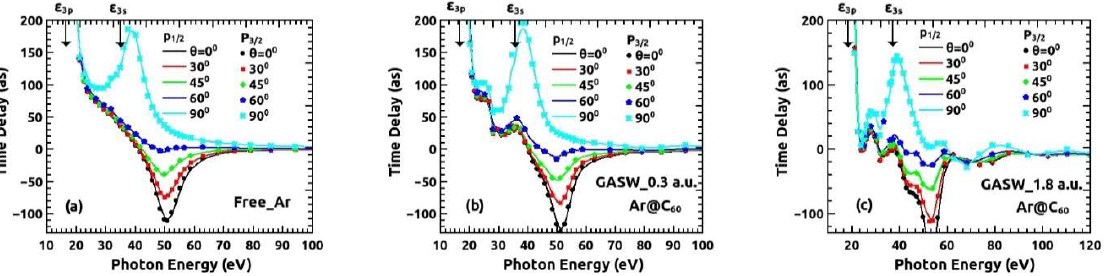
Figure 5. Spin average, angle-dependent time delay of photoionization from the 3p 1/2 and 3p 3/2 subshells of ( a ) free ( left panel ) and confined Ar with the depths of ( b ) 0.3 a.u. ( middle panel ) and ( c ) 1.8 a.u. ( right panel ). Vertical arrows indicate the threshold values of the corresponding subshells used in the RRPA.